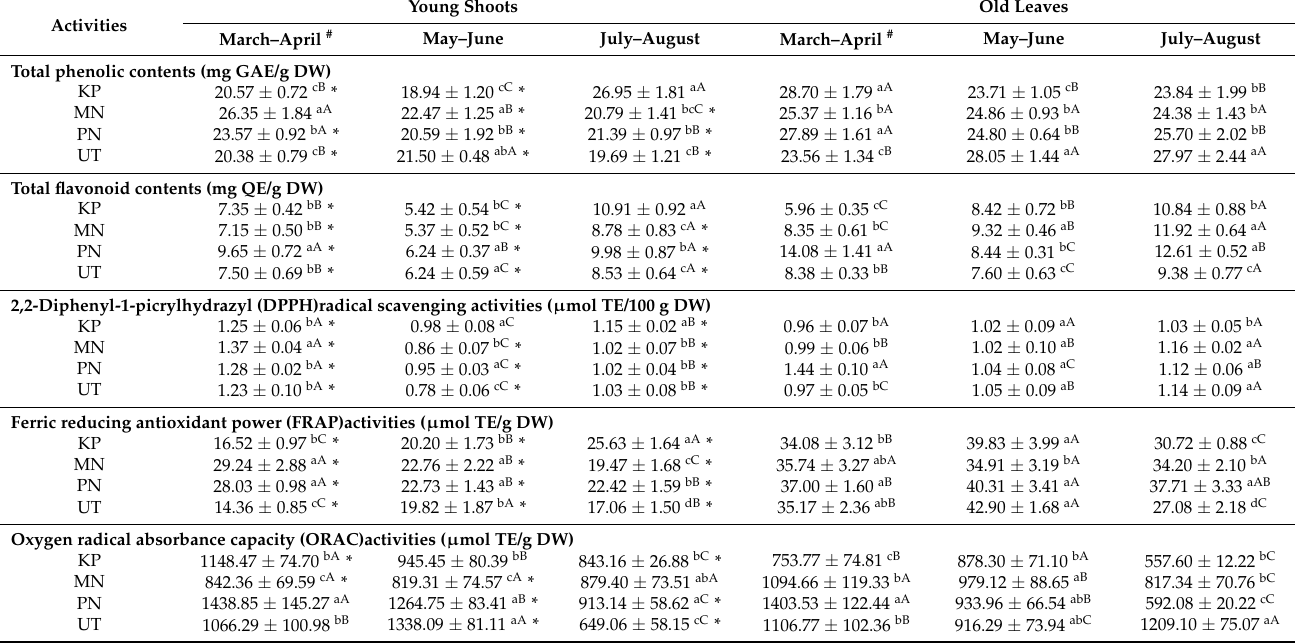
Table 6. Total phenolic contents (TPCs), total flavonoid contents (TFCs), and antioxidant activities in young shoots and old leaves of Adenia viridiflora Craib. from different origins including Kamphaeng Phet (KP), Muang Nakhon Ratchasima (MN), Pakchong Nakhon Ratchasima (PN), and Uthai Thani (UT) collected in different harvesting periods.